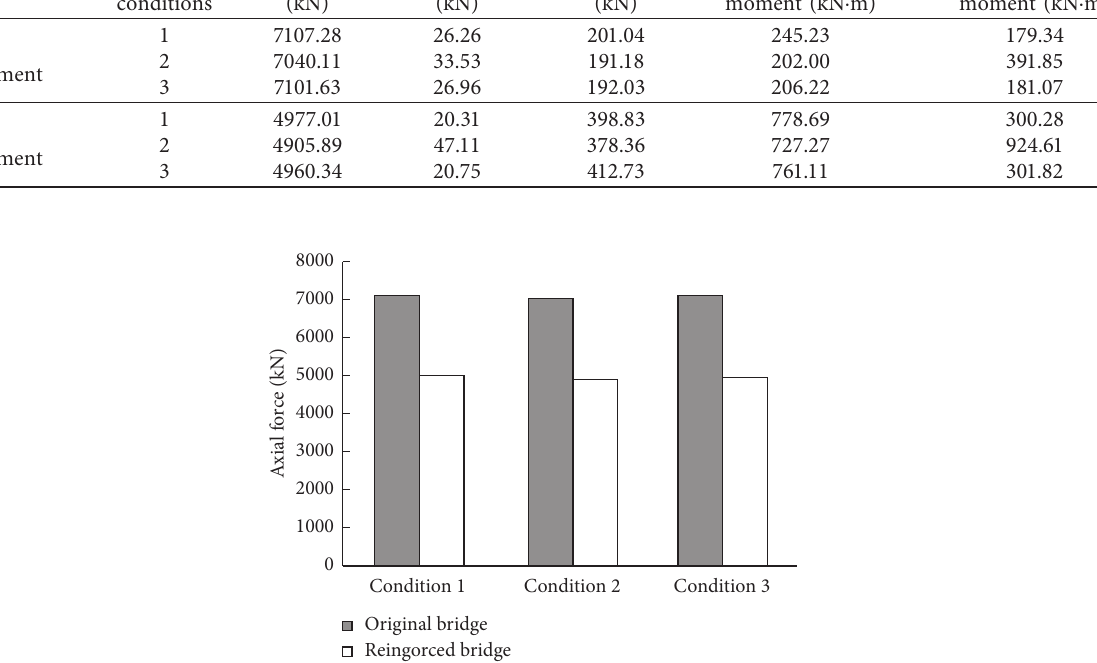
Figure 18: Comparison of peak values of axial force at the fixed end of the bridge before and after reinforcement. Table 9: Comparison of peak values of displacement at 1/2L of the upper of the bridge before and after reinforcement. Bridge status Working conditions Before reinforcement After reinforcement